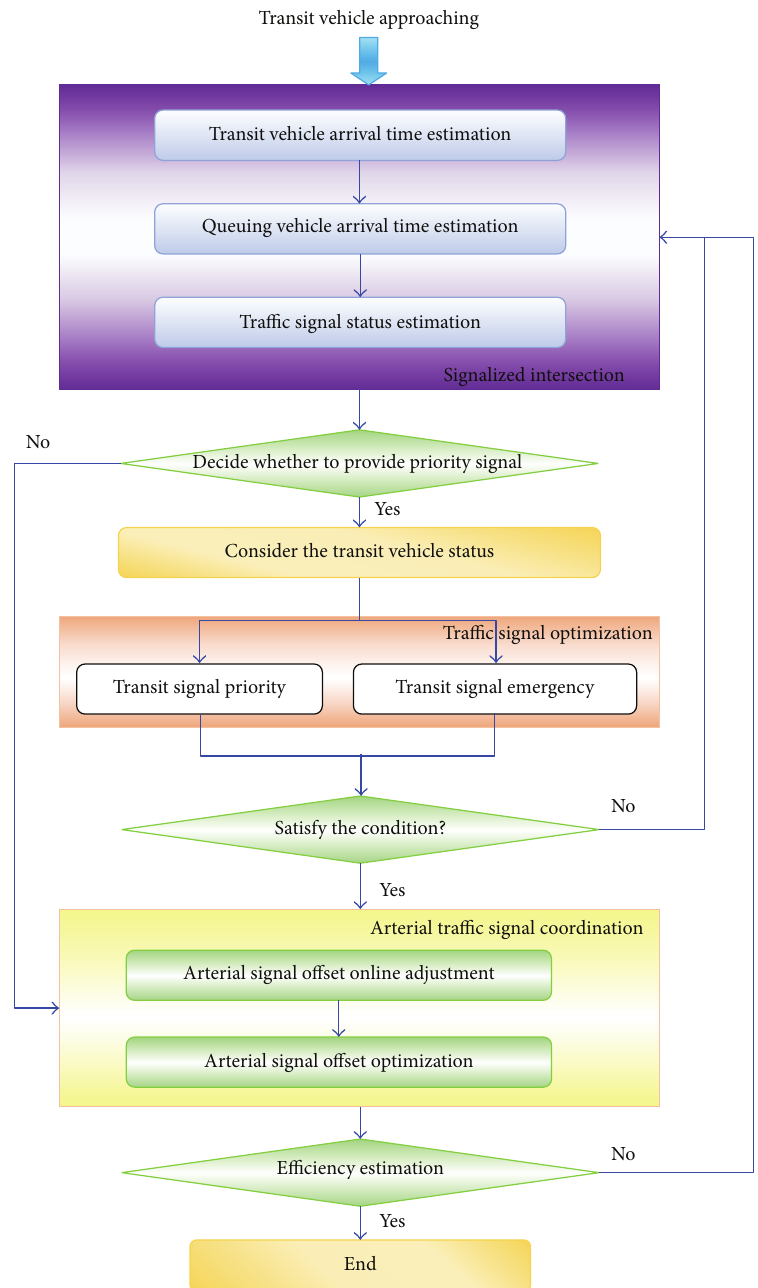
Figure 1: The control logic of transit signal